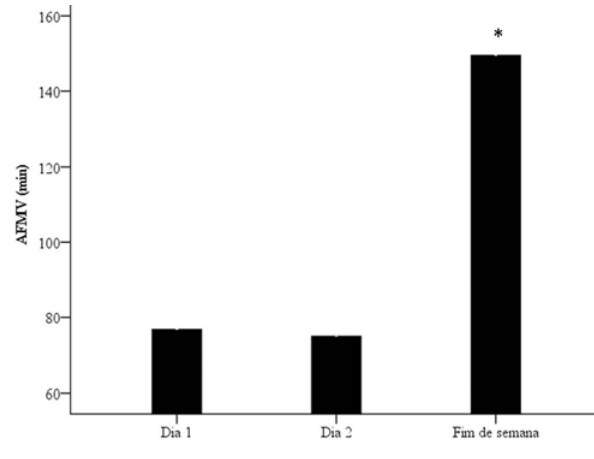
Figura 1. Tempo de envolvimento em atividade física de moderada a vigorosa intensidade durante dois dias de semana e um de final de